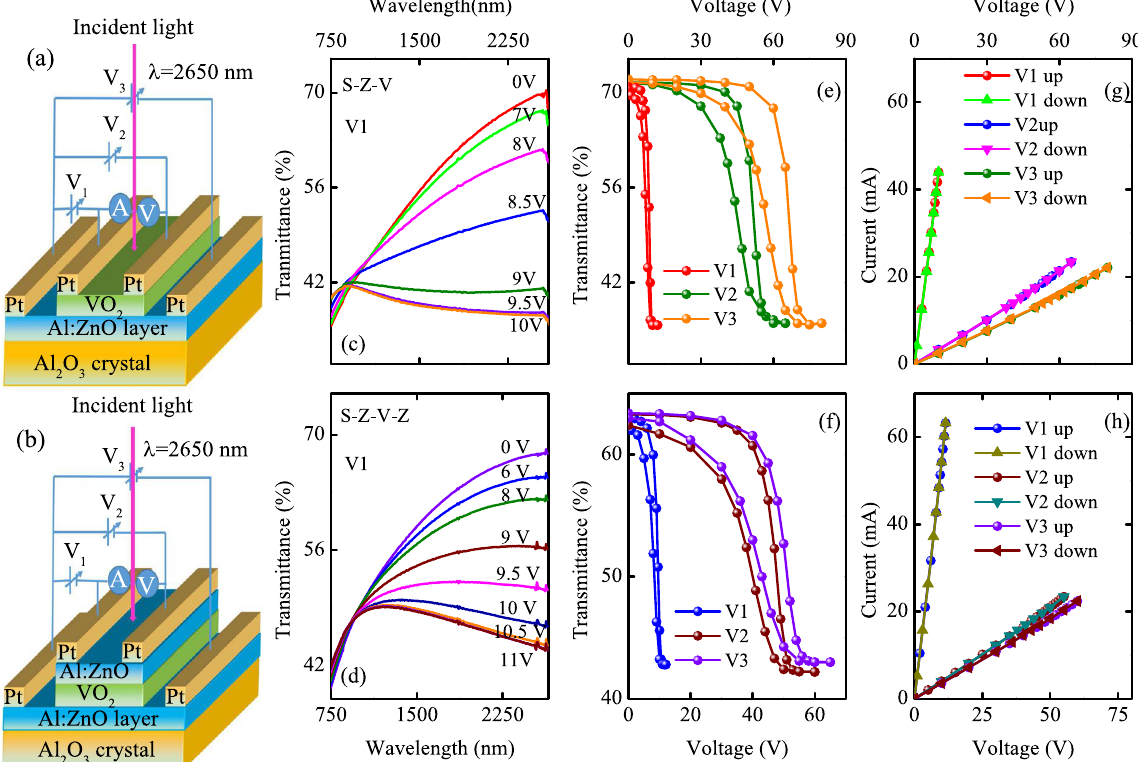
Figure 9. ( a , b ) The schematic shape of the S-Z-V and S-Z-V-Z heterojunctions devices, respectively. ( c , d ) The voltage dependent transmittance of the S-Z-V and S-Z-V-Z devices, respectively. ( e , f ) The hysteresis loop of the transmittance with different voltage at 2650 nm. ( g , h ) The I–V curves of the devices with different